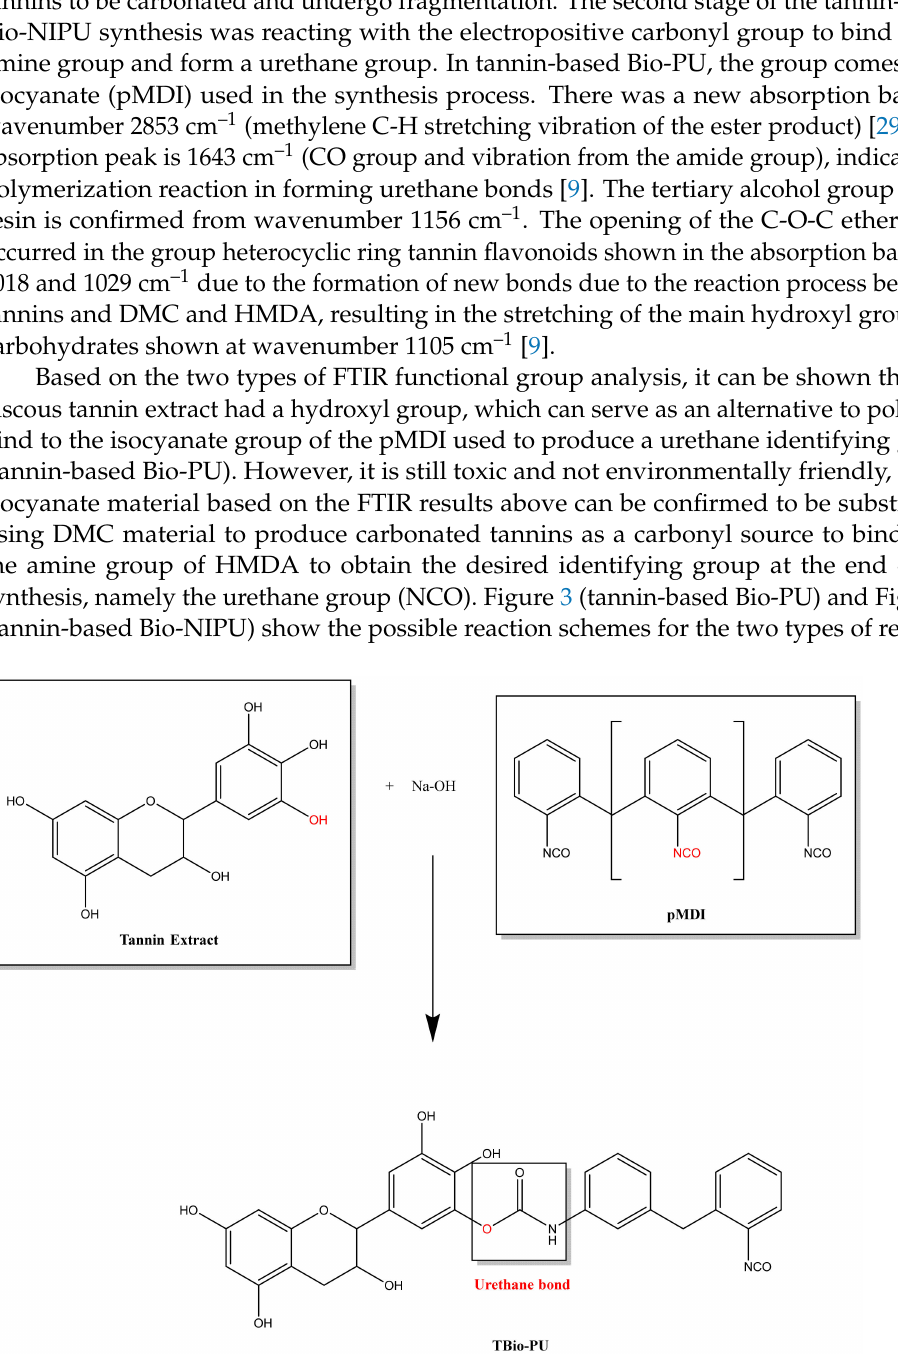
Figure 3. Possible reactions of tannin-based